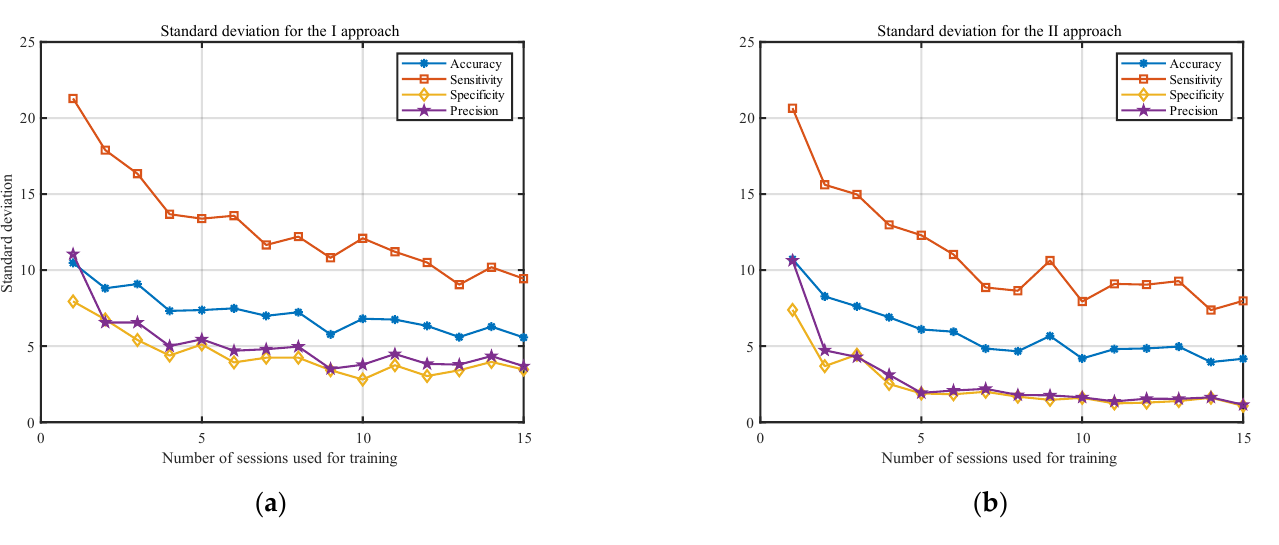
Figure 4. Results for standard deviation, according to the number of sessions used for training, averaged over all participants for the ( a ) I approach and ( b ) II approach. Table 1. Classification measures averaged over all participants obtained for the I approach, in which the raw PSD estimate coefficients were analyzed.